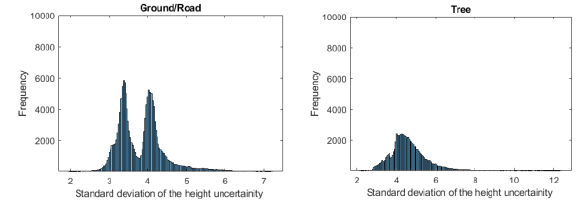
Figure 3. The distribution of the standard deviations of temporal heights in dataset I. The x-axis shows the standard